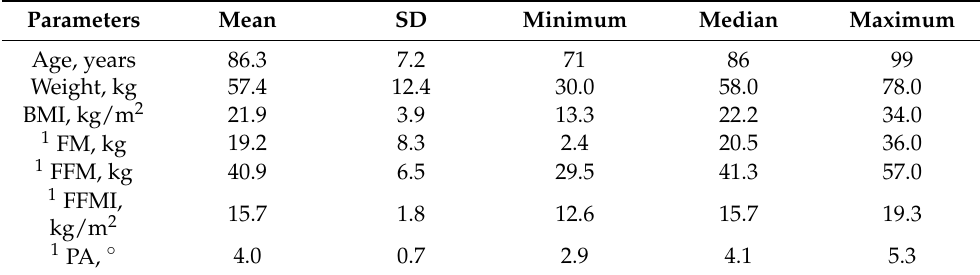
Table 2. Baseline characteristics of the study population ( n = 38).